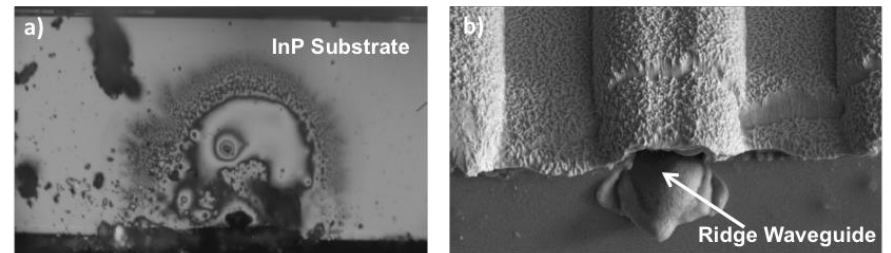
Figure 1. Degradation of front facet of Quantum Cascade Lasers (QCL) evidenced by optical microscopy ( a ) and by scanning electron microscopy ( b ). (SEM photo by courtesy of A. Czerwiński, ITE).